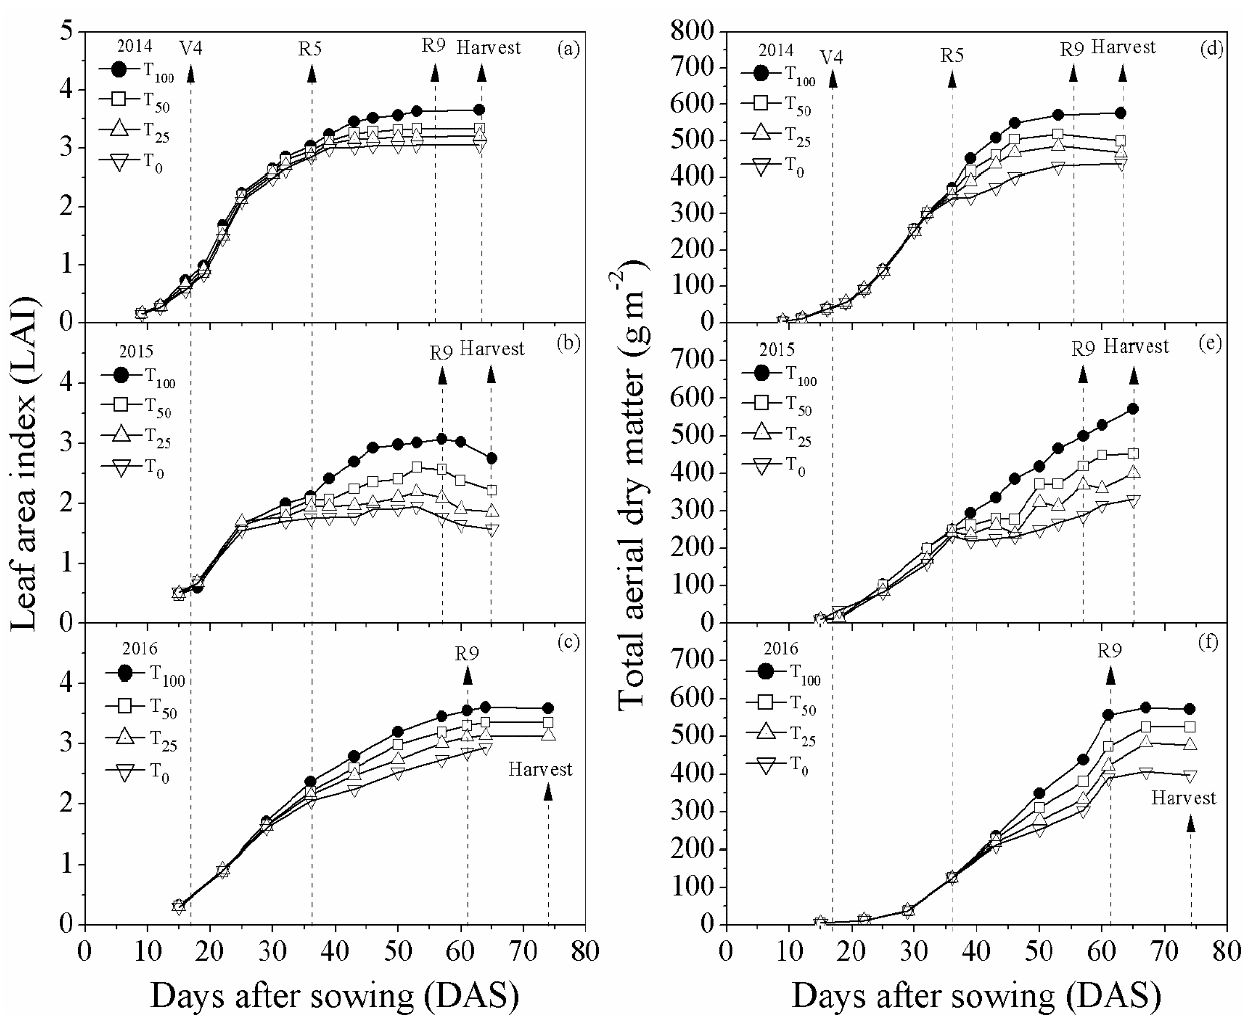
Figure 3. Evolution of leaf area index (LAI) and total aerial dry matter (TADM) as a function of days after sowing in 2014 ( a , d ), 2015 ( b , e ), and 2016 ( c , f ) in Castanhal-PA. V4: Third trifoliate leaf (last vegetative stage); R5: Pre-flowering; R9: Maturation; ● T100: Replacement of 100% of evapotranspi- ration of culture (ETc); □ T50: Replacement of 50% ETc; Δ T25: Replacement of 25% ETc; ▽ T0: Does not have irrigation during the reproductive phase.